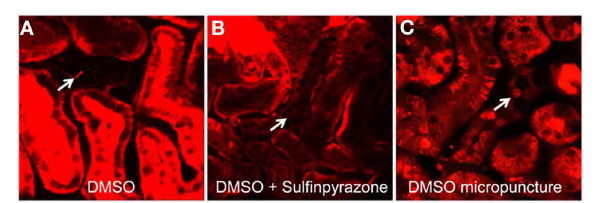
FIGURE 2 | Micropuncture delivery of Rhod-2 results in effective loading of the CD in vivo . Loading of the cells of the CD (arrows) with the calcium fluorophore Rhod-2 in vivo was established by first injecting Rhod-2 dissolved in DMSO alone (A) , or together with Sulfinpyrazone (B) under the renal capsule. Neither strategies resulted in cellular dye uptake in the CD. However, loading of CDs (arrow) were achieved by using micropuncture delivery of Rhod-2 dissolved in DMSO (C)